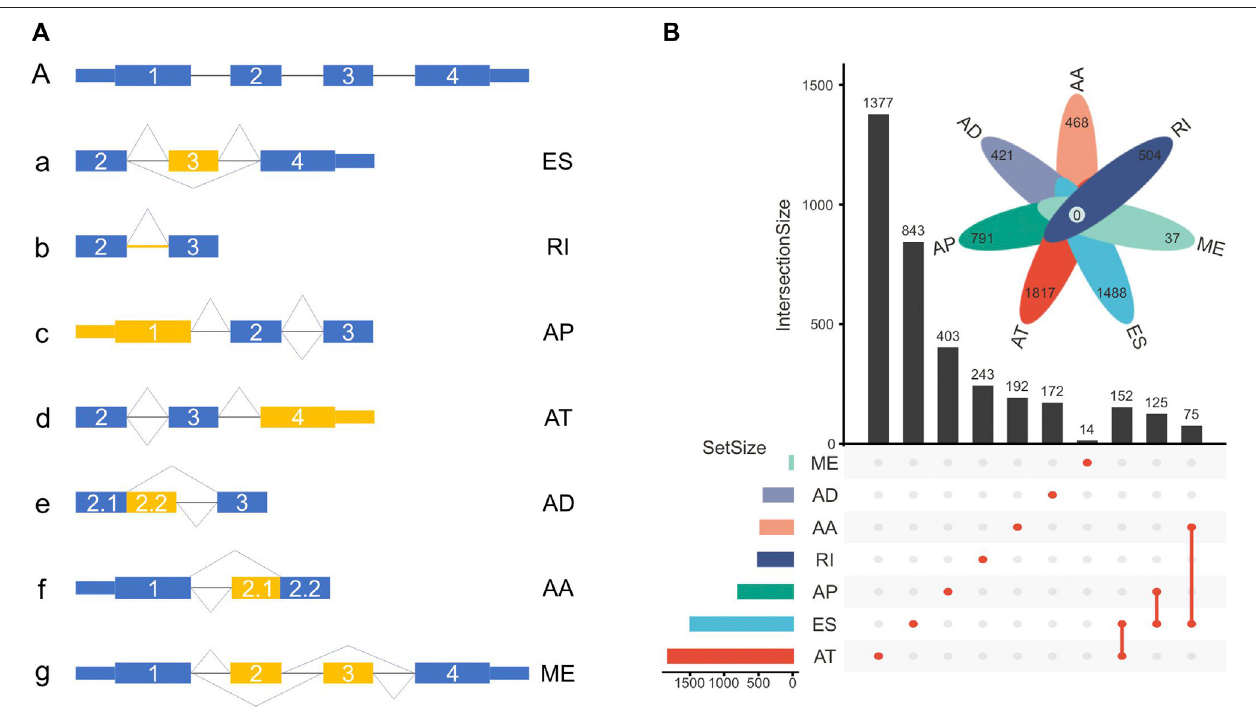
FIGURE 2 | (A) Schematic representation of ASEs, including exon skipping (ES), intron retention (RI), alternative promoter (AP), alternative terminator (AT), alternative donor (AD) site, alternative acceptor (AA) site, and mutually exclusive (ME) exon. (B) The number of genes with ASEs in LUSC, with 3876 ATs in 1817 genes, 2048 ESs in 1488 genes, 1761 APs in 791 genes, 656 RIs in 504 genes, 531 AAs in 468 genes, 515 ADs in 421 genes, and 37 MEs in 37